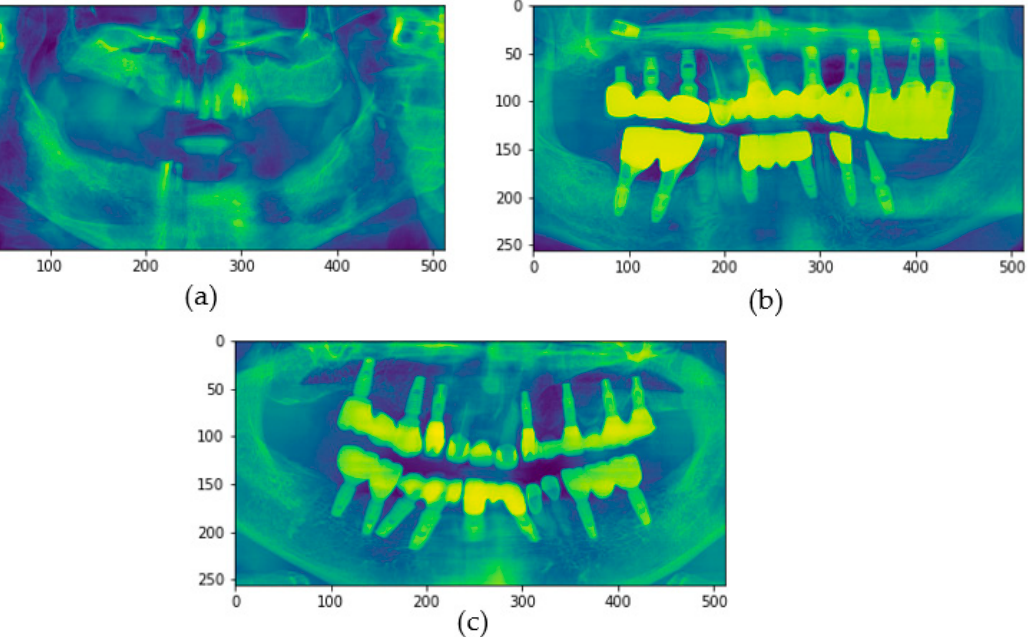
Figure 12. Dental radiographs of persons with dental implants whose dental ages were predicted to be lower: ( a ) actual age is in the 70s, predicted dental age is 55.49; ( b ) actual age is in the 70s, predicted dental age is 52.46; and ( c ) actual age is in the 70s, predicted dental age is 57.99.